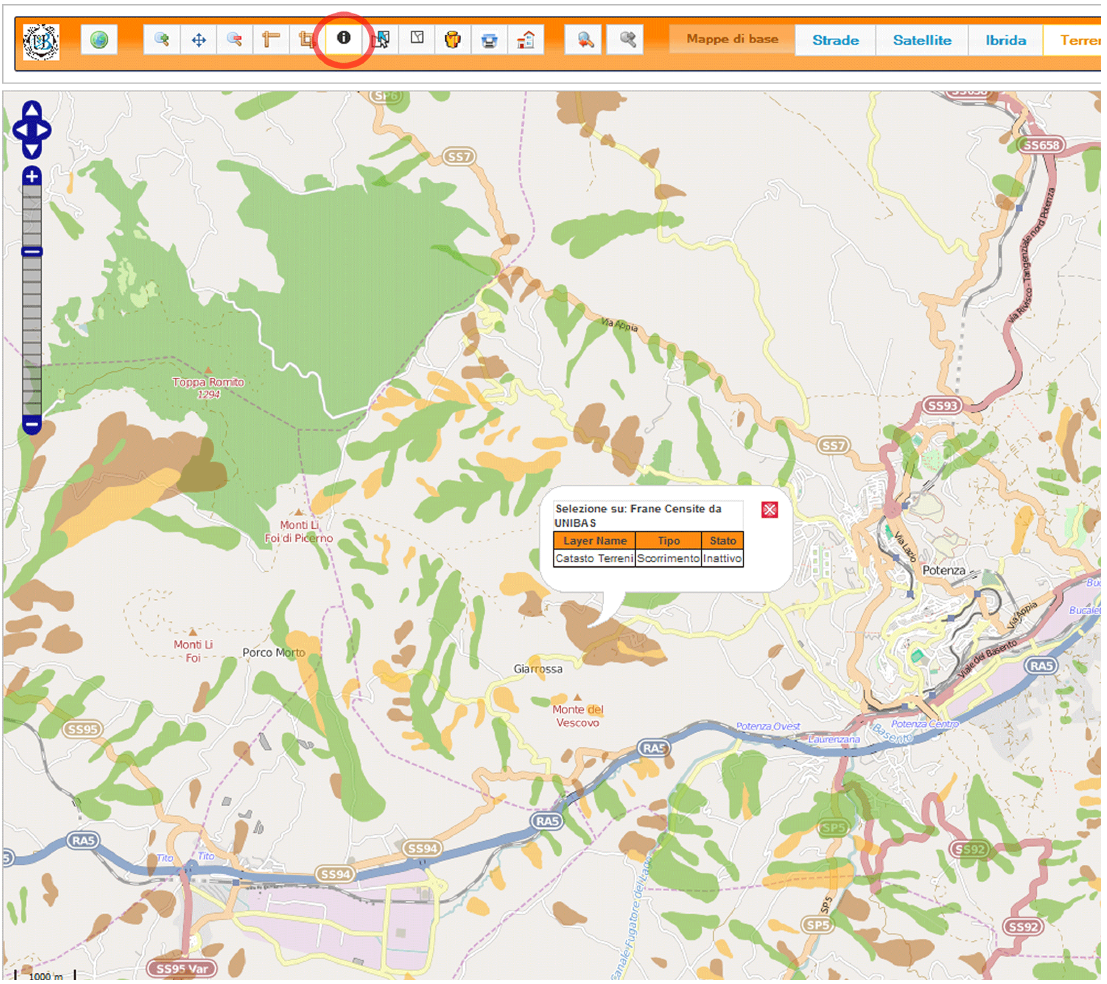
Figure 5. Screenshot of a landslide hazard map visualized in the READY